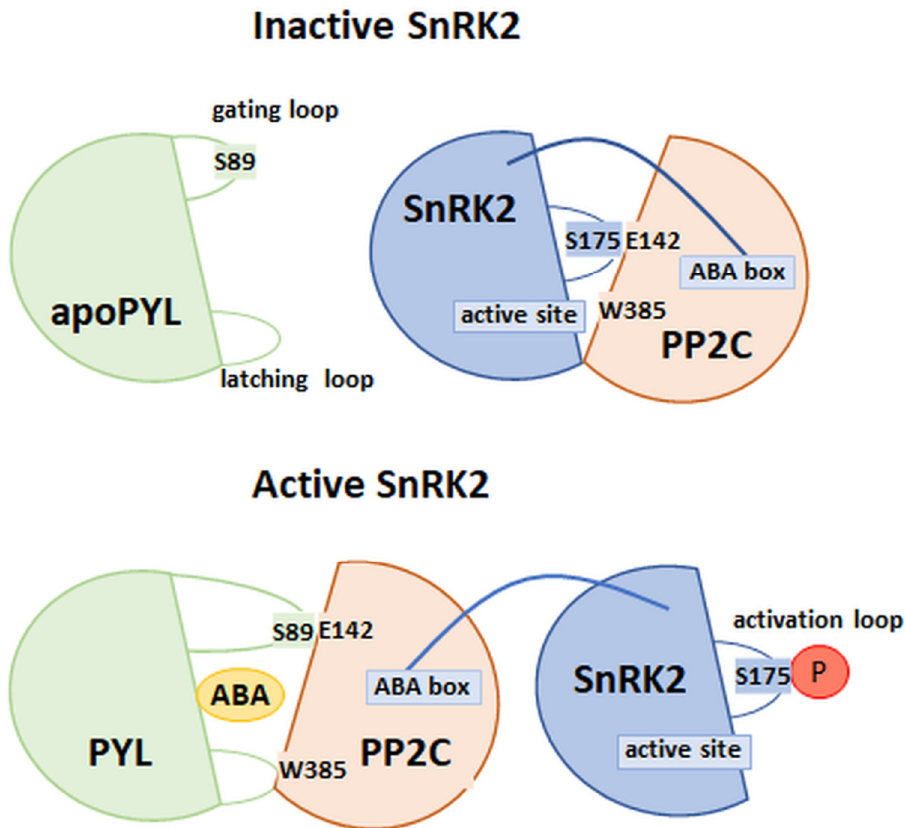
Figure 6. Model of interaction between SnRK2 and PP2C in the absence and presence of ABA. Abbreviations include apoPYL/PYL: ABA receptor (not bound/bound with ABA) with highlighted gate (S89) and latch loops, SnRK2: kinase with highlighted important amino acid position in activation loop (S175: phosphorylation site) and ABA box (interaction with PP2C), PP2C: phosphatase with highlighted W385 and E142 amino acids, as an essential element for activation/inhibition of SnRK2, P: phosphorylation. (Modified from [99]).